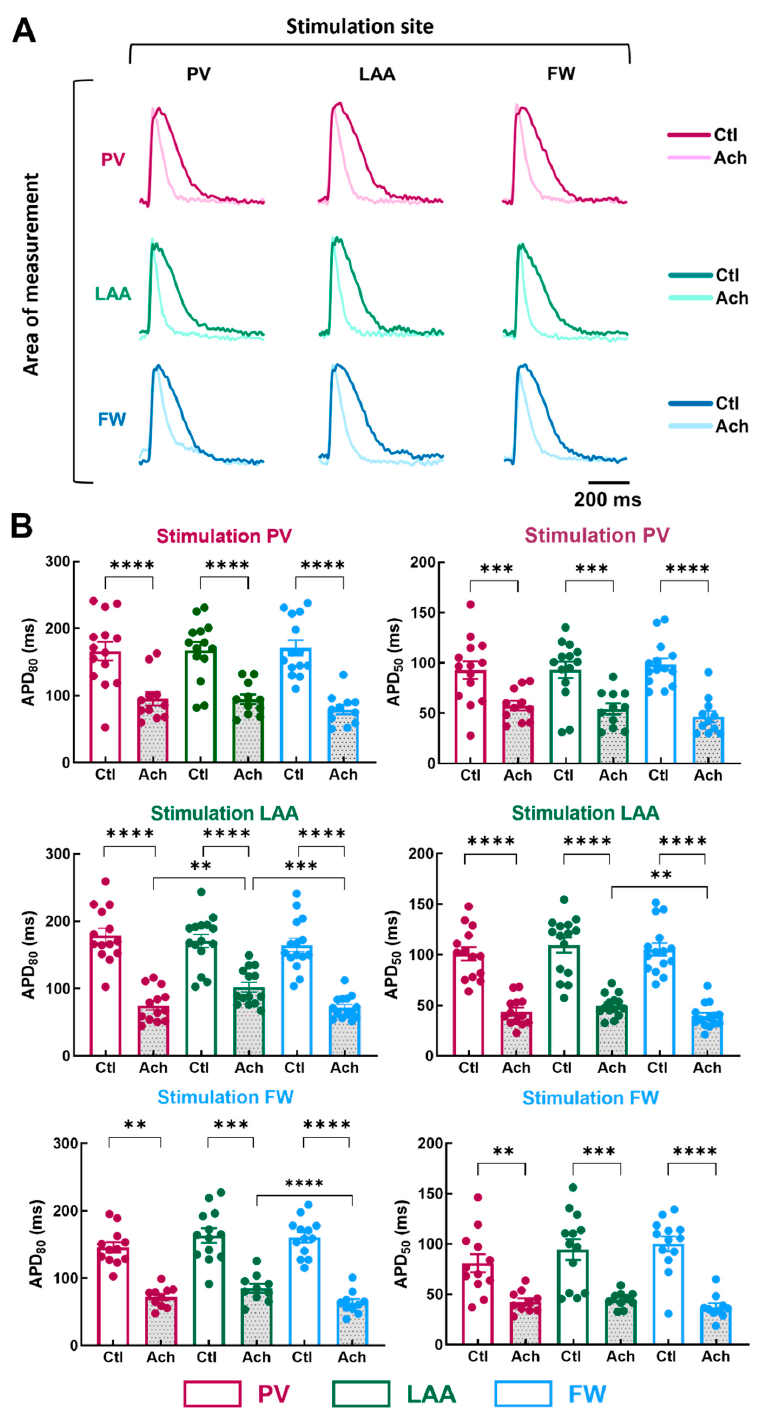
Figure 4. Action potential duration in three regions of the LA by pacing at three different stimulation sites. ( A ) Representative optical action potential under control perfusion (Ctl) or immediately after administration of acetylcholine (Ach 10 μ M) measured in three regions (area of measurements, PV, LAA, FW, top to bottom) at three different pacing sites (PV, LAA, FW, left to right). ( B ) Mean data for action potential duration at 80% (APD 80 , left panel) and 50% (APD 50 , right panel) repolarization at three pacing sites (PV, LAA, FW, top to bottom) measured in three regions PV (purple), LAA (green), FW (blue) under control perfusion (Ctl, open bar) or after administration of acetylcholine (Ach, grey bar). N = 15; One-way ANOVA followed by a Tukey’s multiple comparison test ** p < 0.01, *** p < 0.001, **** p <